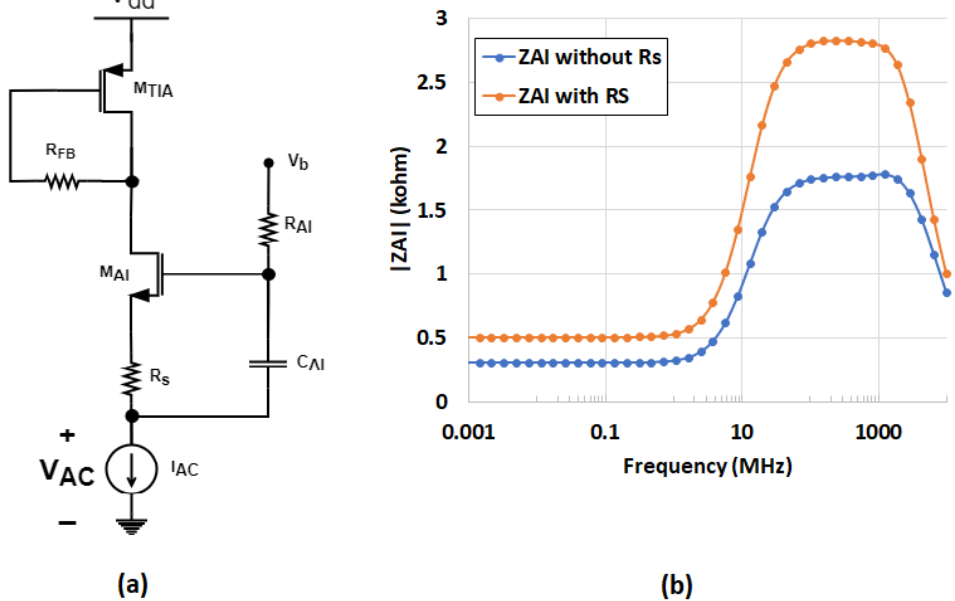
Figure 5. ( a ) Test bench to design the active inductor and ( b ) its impedance magnitude over frequency with and without R S